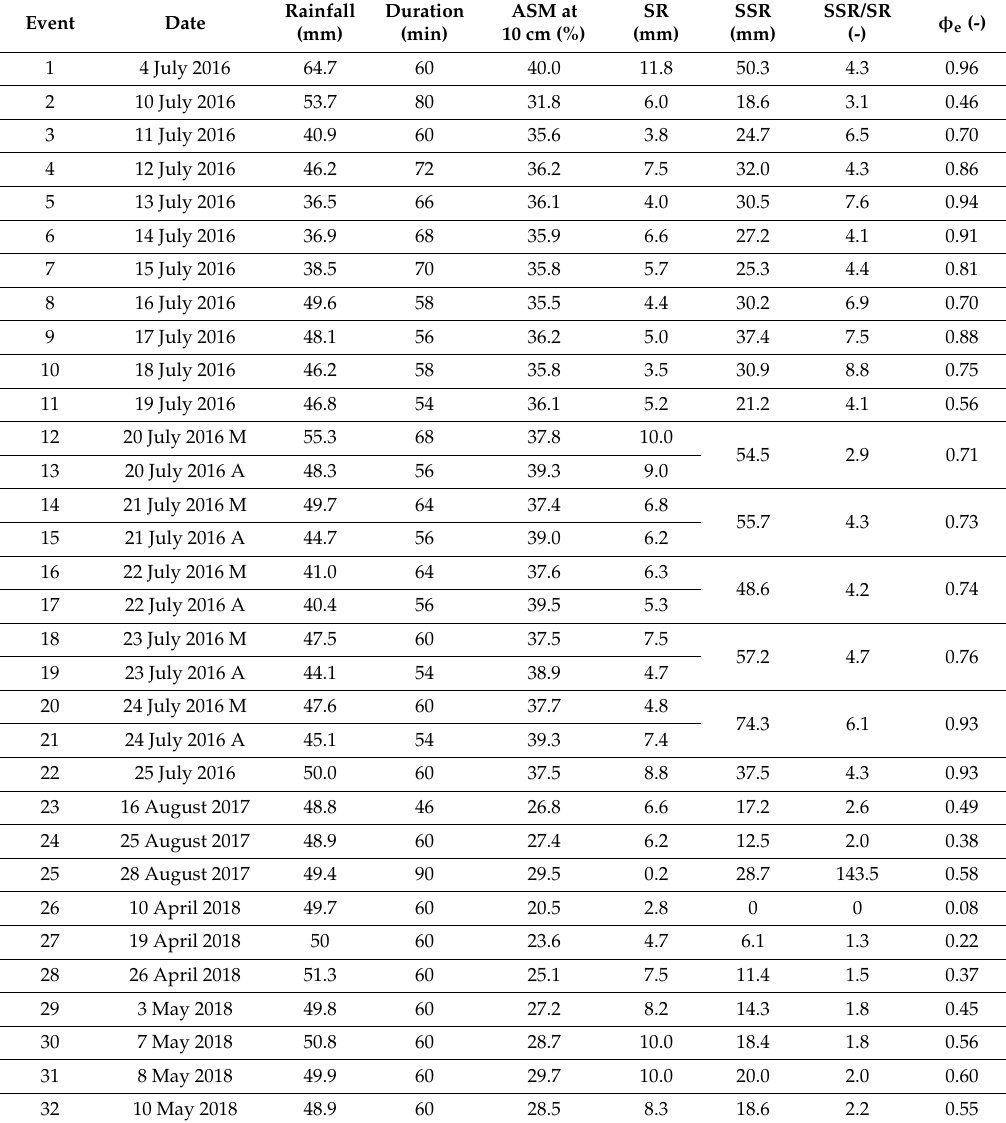
Table 2. Description of the 32 rainfall